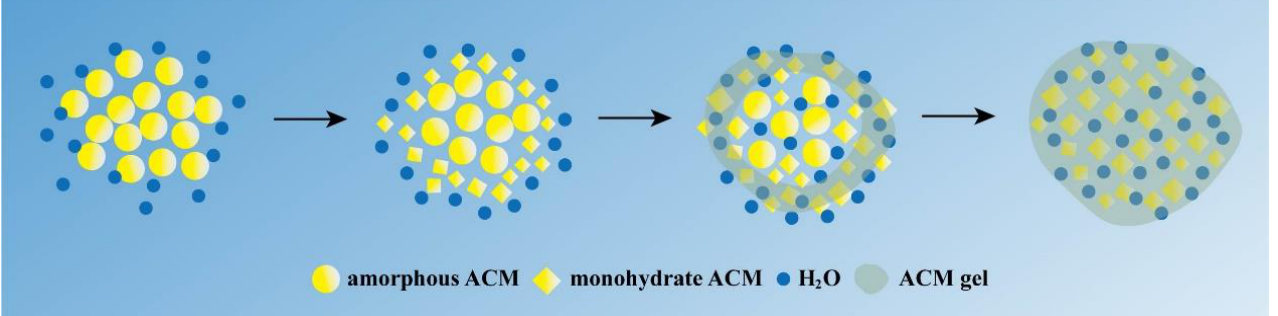
Figure 8. Schematic diagram of gel formation from amorphous ACM.